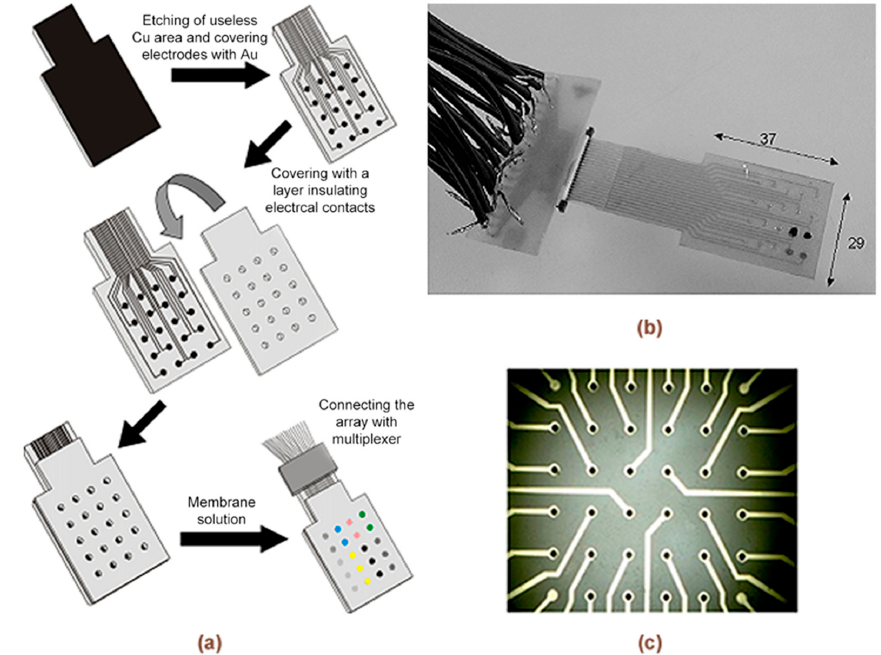
Figure 4. MSA functioning as MSS: preparation by etching and insulation ( a ), photograph of